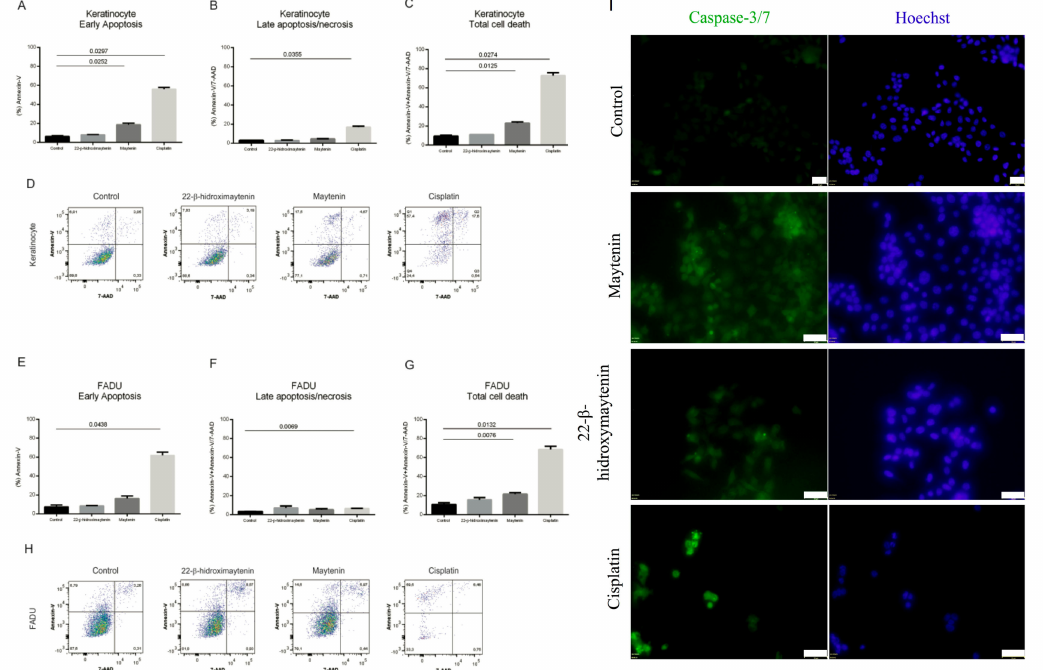
Figure 6. Apoptotic cell death measured by Annexin V and 7-ADD assay and caspase 3 / 7 activation. Keratinocytes and FaDu cell line were treated with 22- β -hydroxymaytenin, maytenin, or cisplatin and the e ff ect on cell death induction was evaluated by flow cytometry using Annexin-V and 7-AAD staining. Keratinocytes: ( A ) Early apoptosis, ( B ) late apoptosis, ( C ) total cell death and ( D )